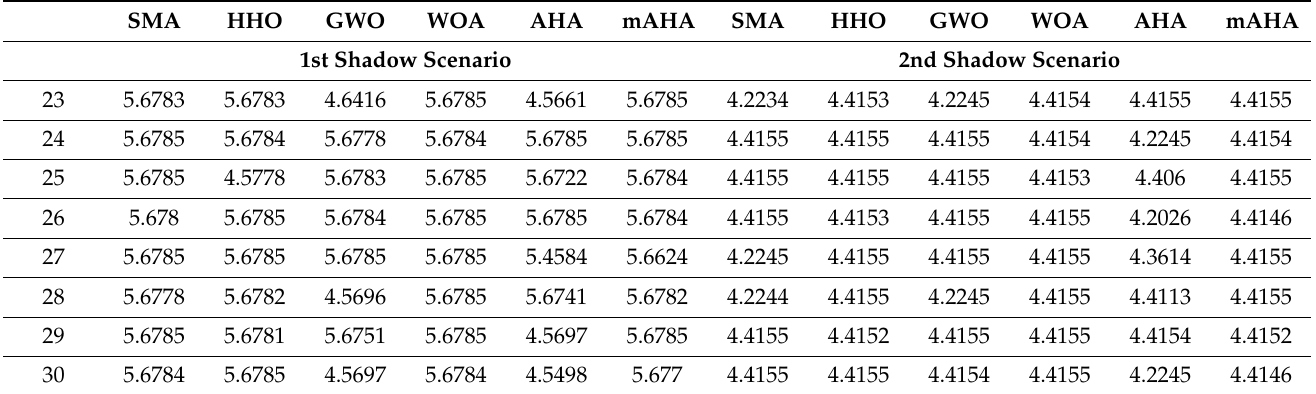
The two shadow scenarios are shown in Table 7, where the proposed mAHA has the best performance compared to other algorithms. For the first scenario, the average PV power values varied between 2716.754 W and 2067.039 W. mAHA achieves the maximum PV power of 2716.754 W, which is matched by HHO (2186.705 W). The minimum PV power of 2067.039 W is achieved by AHA. Thus, the proposed mAHA increases the PV power by 31.3% compared to the original AHA. The values of STD vary from 0.004308 to 0.516302. The minimum STD of 0.004308 is achieved by mAHA, followed by SMA (0.246108). The worst value of STD of 0.516302 is achieved by AHA. For the second shadow scenario,